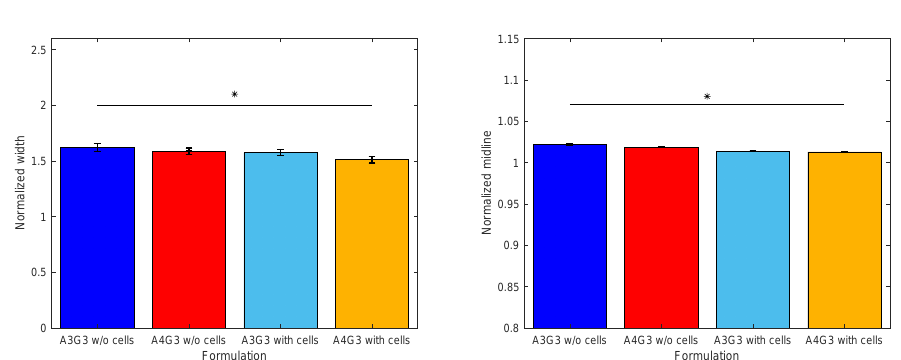
Figure 6. Printing accuracy study for the circle structure. In ( A ), the normalized line width is shown and, in ( B ), the normalized radius to the midline. For all four formulations, three biological replicates ( n = 3) were produced and eight technical replicates ( n = 8) printed for each structure resulting in total in 24 objects, of which the mean is shown in a bar with the associated standard deviation. Significant differences are denoted with an asterisk ( p <